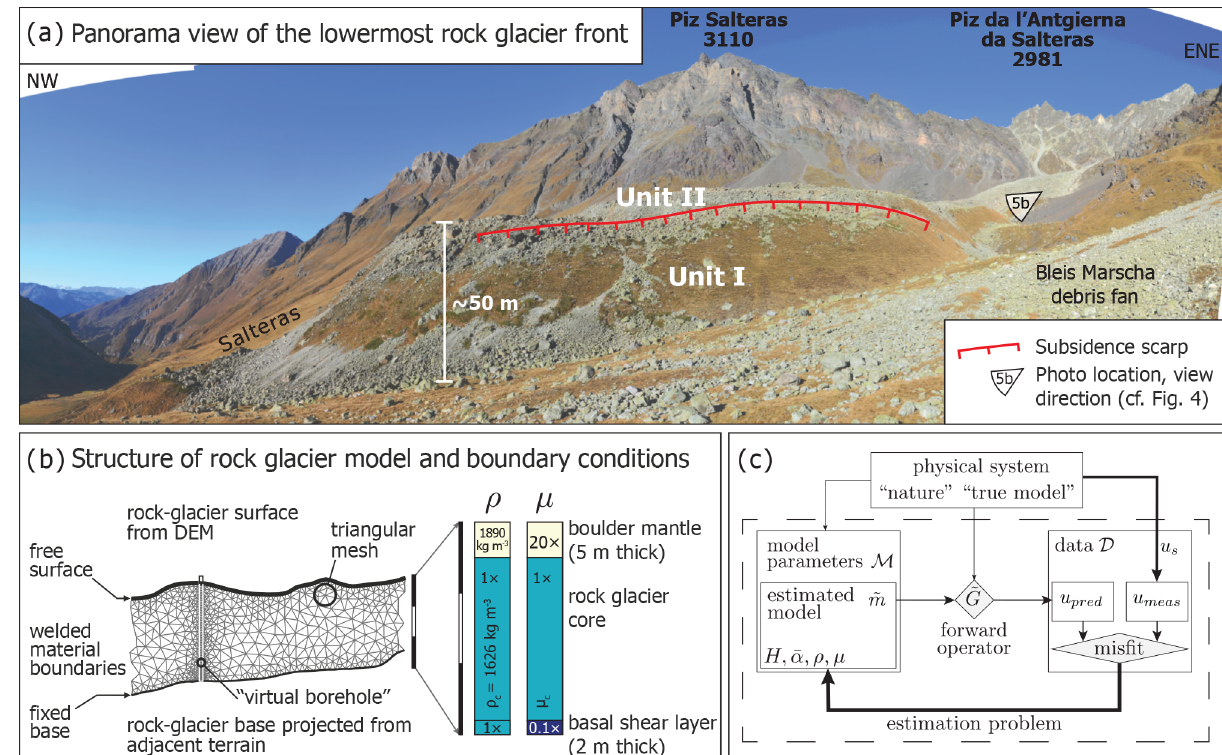
Figure 2. (a) Side view of the lowermost front, rising 30–50m above the Salteras trough shoulder (see Fig. 4 for photo location and view direction). A stabilized, grassy sidewall extends upstream beneath younger lobes. The southernmost fringe is subsiding possibly due to ice loss. (b) Finite element (FE) model setup, triangular mesh (Shewchuk, 1996), boundary conditions, and prescribed ratios of density ρ and dynamic viscosity µ (profiles). The surface boundary is the well-constrained elevation along a longitudinal profile, extracted from the DEM as a swath profile with TopoToolbox. The a priori prescribed density and viscosity ratios create the characteristic mechanical layering of rock glaciers with a stiff, high-viscosity boulder mantle, deformable core, and weak, low-viscosity basal layer. (c) Inverse problem structure with the model parameters ˜ m that are linked to the observable data u s via the discrete forward operator ˜ G , the FE model. The model predicts a synthetic surface velocity u pred from the mechanical parameters that control the rock glacier creep: thickness H , average surface slope ¯ α , density ρ , and dynamic viscosity µ . A combination of parameter values for (H, ¯ α, ρ, µ) that produces synthetic surface velocities u pred whose misfit to the observed data u meas is equal to or smaller than the measurement uncertainties is one solution to the inverse problem. Starting from an initial guess, the rock glacier model ˜ m = (H, ¯ α, ρ, µ) is iteratively refined until a solution is found (estimation